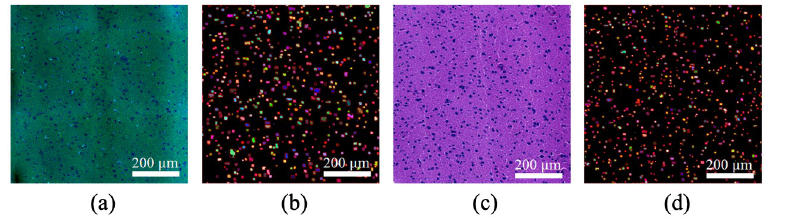
Fig 6. Cell segmentation and identification results in a FOV. A: SRS FOV. B: SRS Cell identification. C: H&E FOV; D: H&E Cell identification.